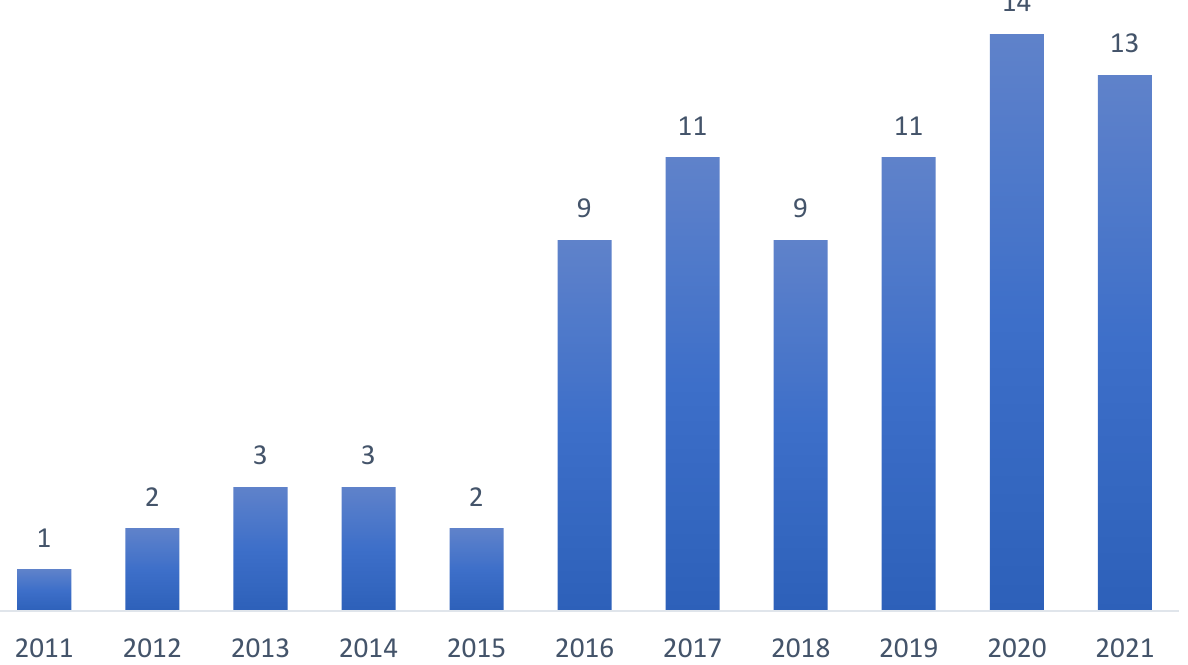
Figure 3. Publication year distribution of the literature.